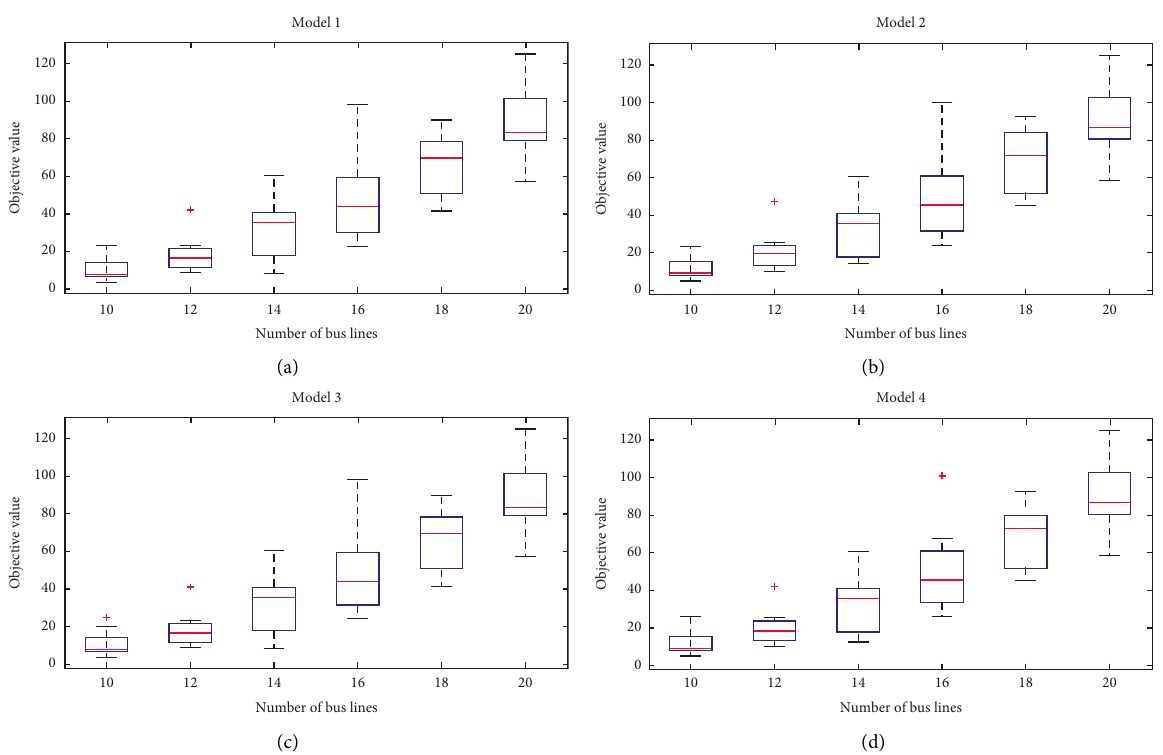
Figure 6: Objective value from the four proposed models with varying bus routes. (a) Model 1’s objective value. (b) Model 2’s objective value. (c) Model 3’s objective value. (d) Model 4’s objective